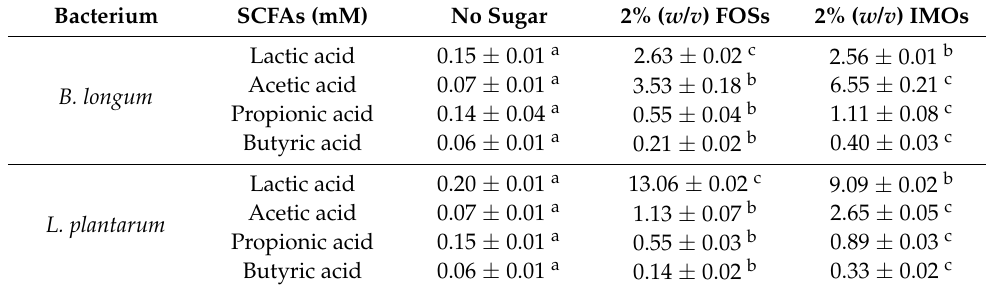
Table 3. Production of SCFAs by B. longum and L. plantarum grown at 37 ◦ C for 24 h. FOSs, fruc- tooligosaccharides; IMOs, isomaltooligosaccharides obtained from B. subtilis strain AP-1. Bacterium SCFAs (mM) No Sugar 2% ( w / v ) FOSs 2% ( w / v ) IMOs Lactic acid 0.15 ± 0.01 a 2.63 ± 0.02 c 2.56 ± 0.01 b Acetic acid 0.07 ± 0.01 a 3.53 ± 0.18 b 6.55 ± 0.21 c B. longum Propionic acid 0.14 ± 0.04 a 0.55 ± 0.04 b 1.11 ± 0.08 c Butyric acid 0.06 ± 0.01 a 0.21 ± 0.02 b 0.40 ± 0.03 c Lactic acid 0.20 ± 0.01 a 13.06 ± 0.02 c 9.09 ± 0.02 b Acetic acid 0.07 ± 0.01 a 1.13 ± 0.07 b 2.65 ± 0.05 c L. plantarum Propionic acid 0.15 ± 0.01 a 0.55 ± 0.03 b 0.89 ± 0.03 c Butyric acid 0.06 ± 0.01 a 0.14 ± 0.02 b 0.33 ± 0.02 c Different letters indicate significant differences (Tukey test, p < 0.05) in the same